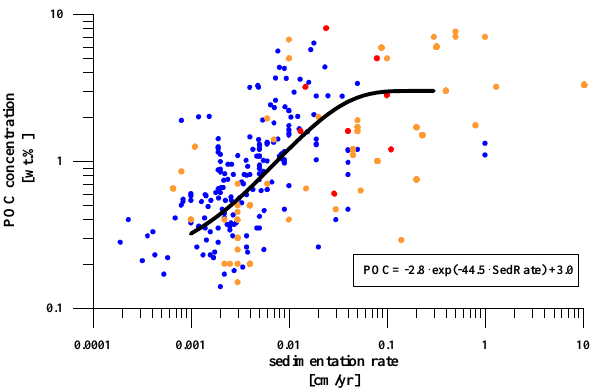
Fig. 10. POC concentrations vs. sedimentation rates after Seiter et al. (2004) (blue dots), Colman and Holland (2000) (yellow dots), and the ODP Sites used in this study (red dots) (references are listed in the text). The black line indicates the function derived for the sensitivity analysis of the numerical model.